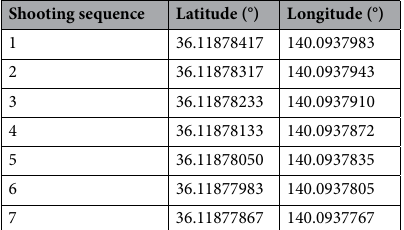
Table 2. Examples of a shooting a sequence and